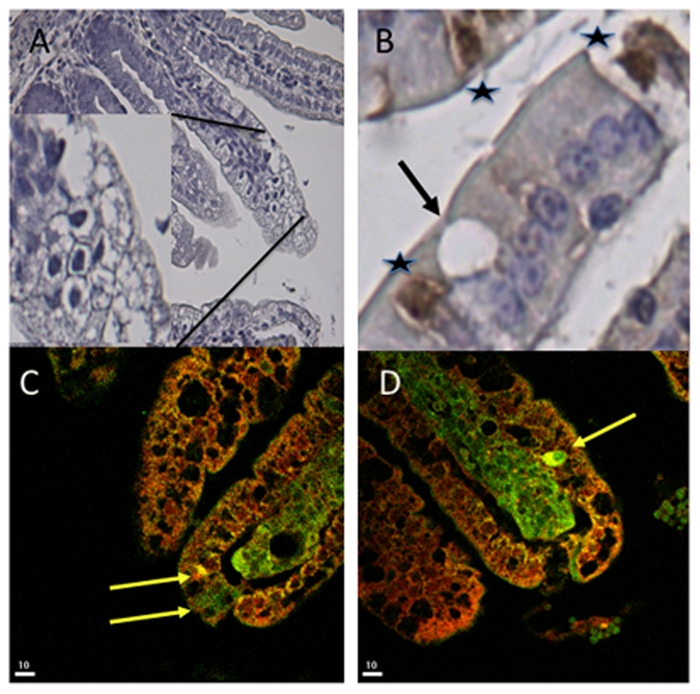
Co-localization of rotavirus and 5-HT in EC tumor cells.(A) Haematoxylin-stained jejunum of RV-infected mice. The picture shows extensive vacuoles characteristic of RV-infected enterocytes at 48 h p.i. (B) Sections of infected intestinal tissue were processed for immunohistochemistry for detection of EC cells with chromogranin A-specific antibodies. Stars indicate EC cells and the arrow identifies a vacuole in the close vicinity of an EC cell in the ileum. (C, D) Sections of jejunum intestinal tissue were stained for RV (red) and 5-HT (green). Arrows indicate EC cells with co-localization (yellow) of the virus and 5-HT.